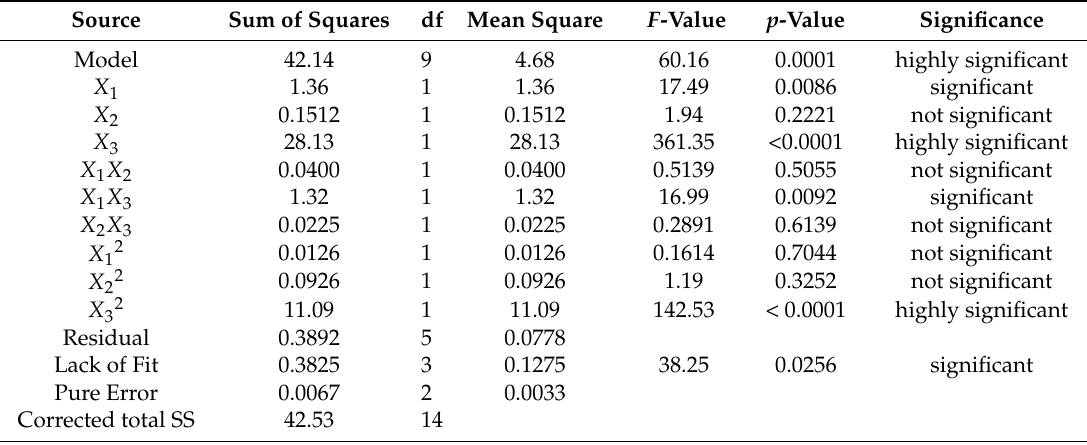
Table 3. ANOVA results for response variable R 1 .